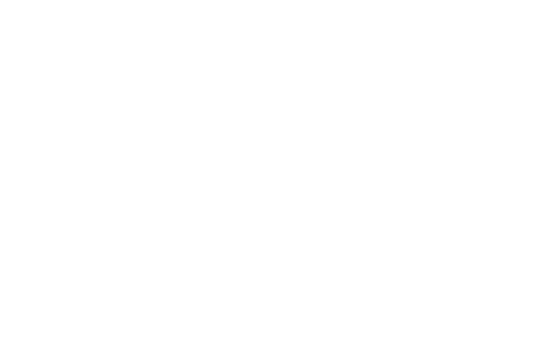
Figure 18. Explanation of minimum (residual) torque transmitted by a